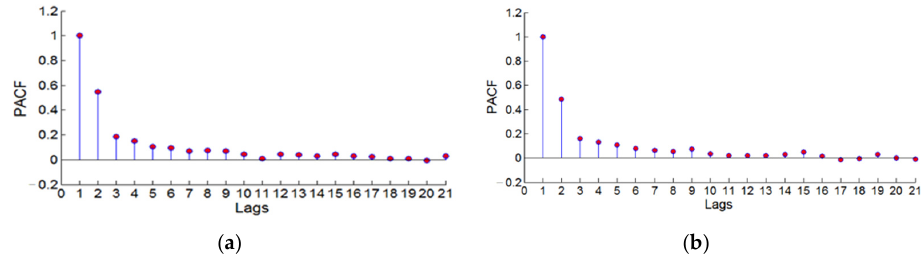
Figure 11. The partial autocorrelation graph of bjfs and lhaz CORS stations height residual sequence. ( a ) bjfs and ( b ) bogo.